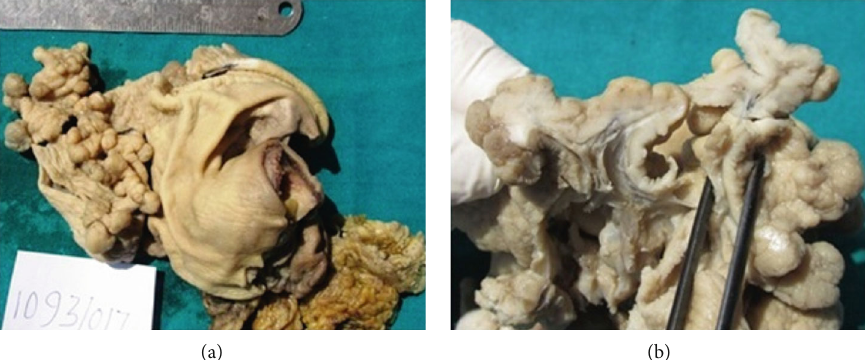
Figure 2: (a) Gross specimen of the stomach with multiple polypoidal lesions in the body with a normal-looking surrounding mucosa. (b) Cut section through polypoidal lesions showing mucosal thickening not extending beyond the submucosa.